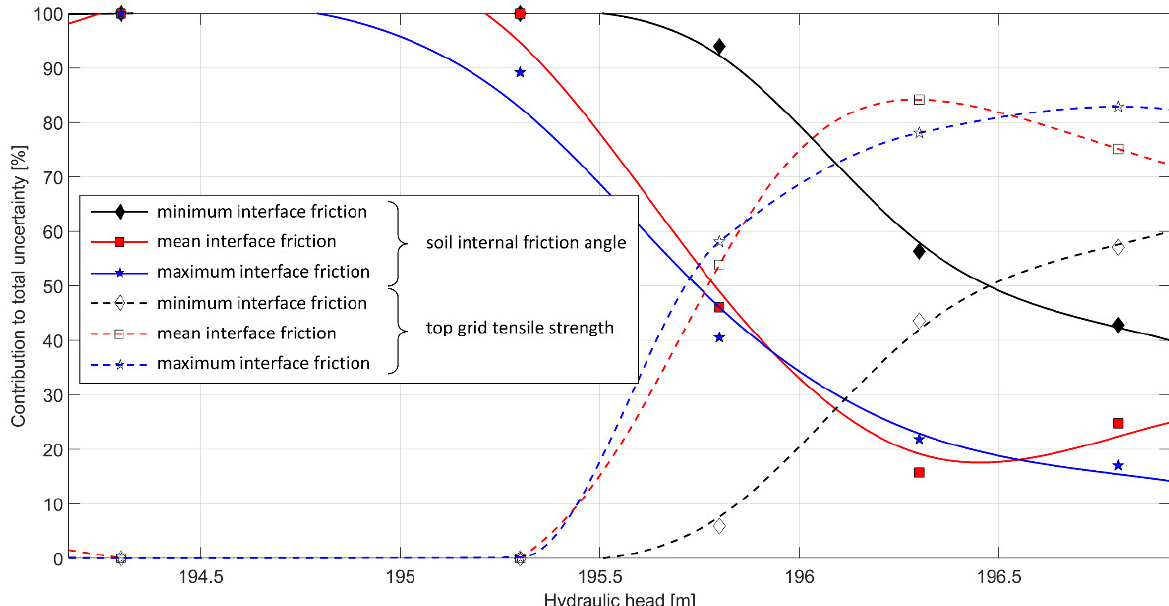
Figure 16. Relative contribution of internal friction’s and top grid’s uncertainty to total uncertainty for LSF15, for all three interface friction angles (full lines refer to internal friction angle, dashed lines refer to top